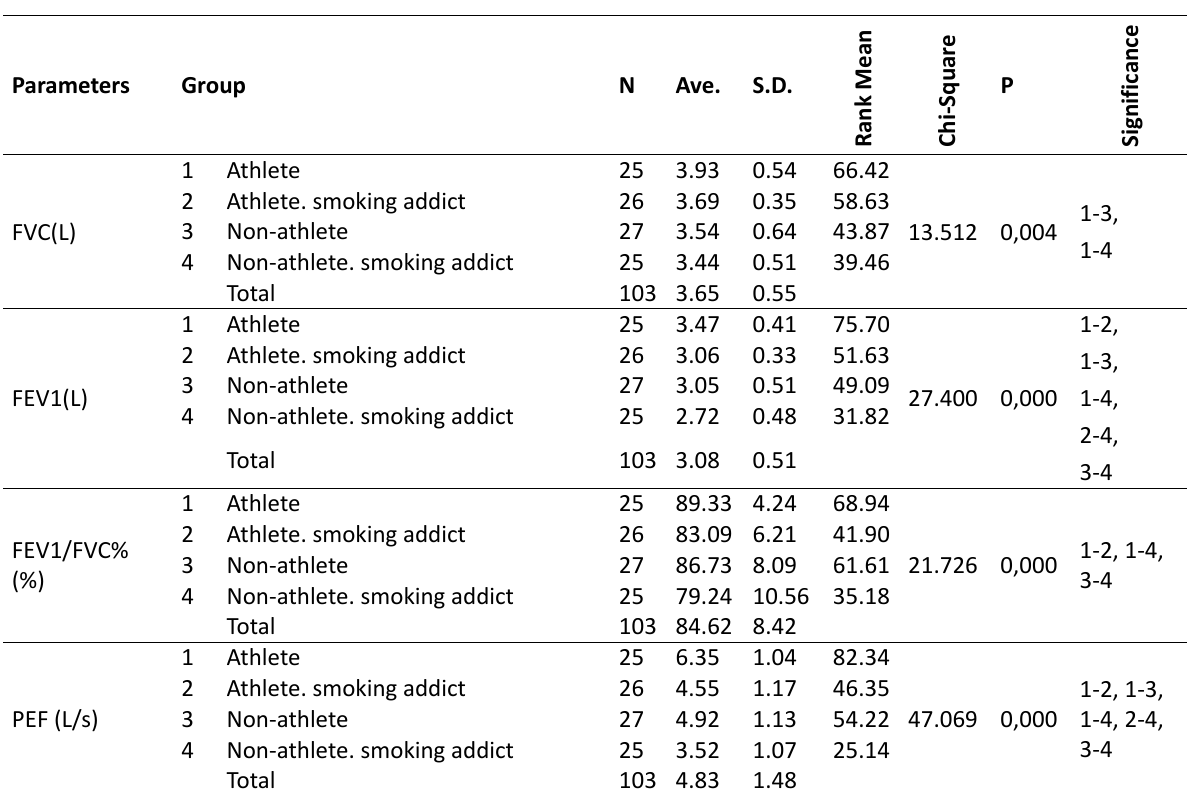
Table 2. Respiratory function analyses of female university students